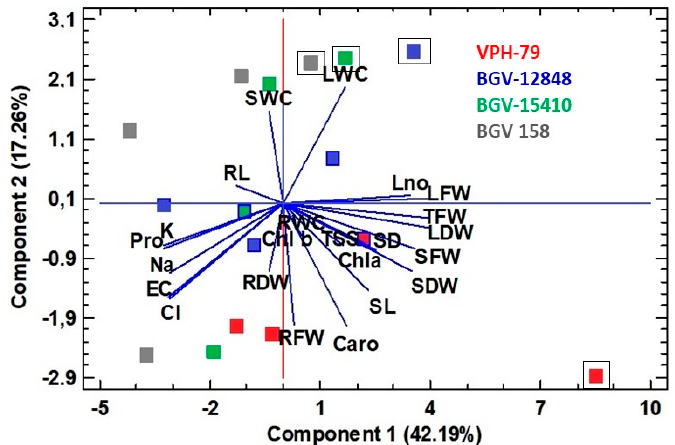
Figure 3. Principal component analysis (PCA). Changes in growth parameters, photosynthetic pigments monovalent ions, and osmolytes concentrations in plants growth under salt stress conditions for three weeks, with respect to the corresponding control, non-stressed plants of the four local cultivars of Phaseolus lunatus : VPH-79 (red), BGV-12848 (blue), BGV-15410 (green), and BGV 158 (grey). Squares surrounded by a box correspond to control treatments. The percentages of the total variability explained by the first two components are shown (in parentheses) on the X and Y axes, respectively. Abbreviations: EC, substrate electric conductivity; RL, root length; RFW, root fresh weight, RDW, root dry weight; RWC, root water content; SL, stem length; SD, stem diameter; SFW, stem fresh weight; SDW, stem dry weight; SWC, stem water content; Lno, leaf numbers; LFW, leaf fresh weight; LDW, leaf dry weight; LWC, leaf water content; TFW, total fresh weight; Chl a, chlorophyll a; Chla b, chlorophyll b; Caro, carotenoids; Na, sodium; K, potassium; Cl, chlorine; Pro, proline; TSS, total soluble sugars.